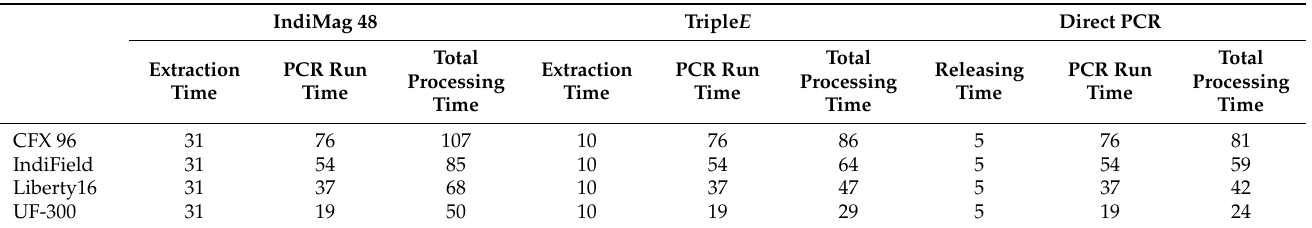
Table 2. Comparison of extraction/releasing time, qPCR run time, and total processing time for the tested extraction/releasing methods and real-time PCR cyclers (in min). IndiMag